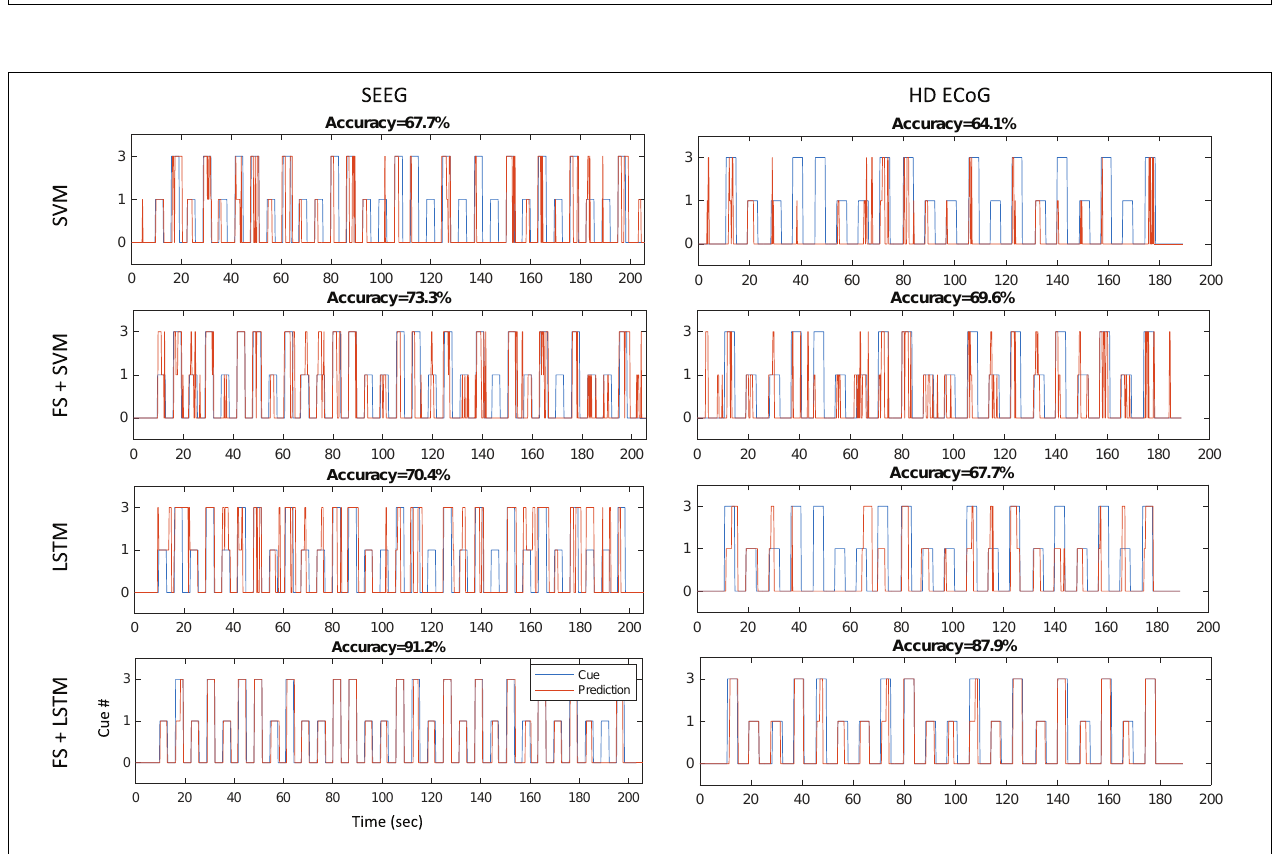
FIGURE 5 | Amplitude modulation and electrode placement in P3 (ECoG and strip electrodes). (A) Averaged (across trials) temporal patterns of amplitude modulation in various frequency bands for motor and sensory tasks. (B) Electrode placement in various surface regions of the brain.